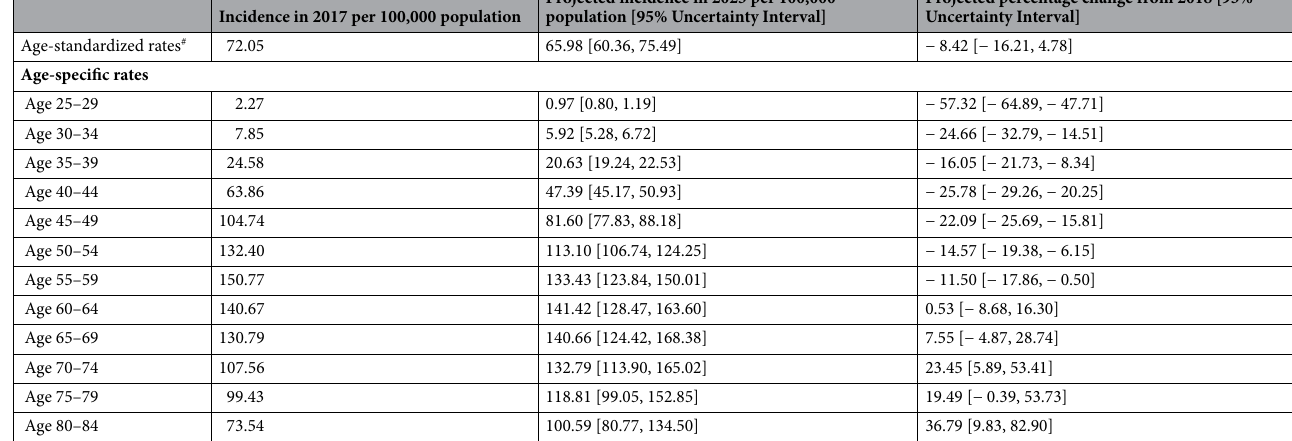
Table 1. Age-standardized and age-specific oral cancer incidence per 100,000 population (observed rates in 2017 and projected rates for 2025) and projected percentage changes from 2018 to 2025. # The World Health Organization 2000 World Standard Population was used to compute the truncated age-standardized incidence rates (age 25–84 years), see Table